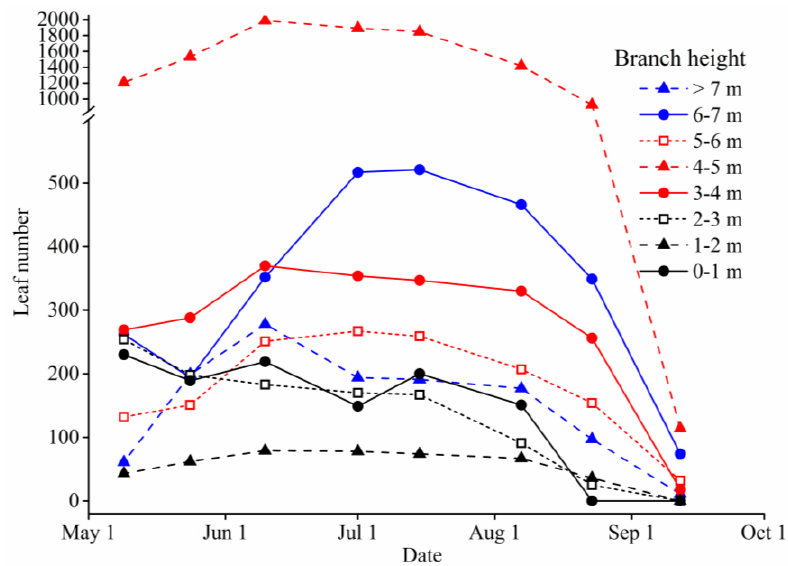
Figure 4. Variation of the leaf number on branches from different branch heights (Figure 1) of the sample tree.